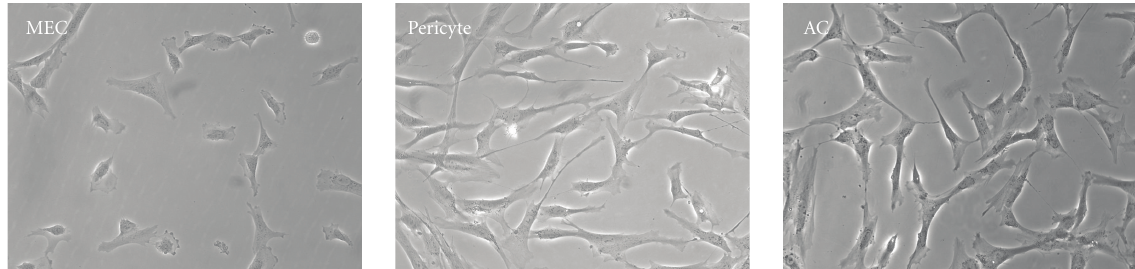
Figure 1: Distinct morphology of the three purified subpopulations of human blood-vessel-derived stem cells (hBVSCs) in culture: myogenic endothelial cell (MEC), pericyte, and adventitial cell (AC)